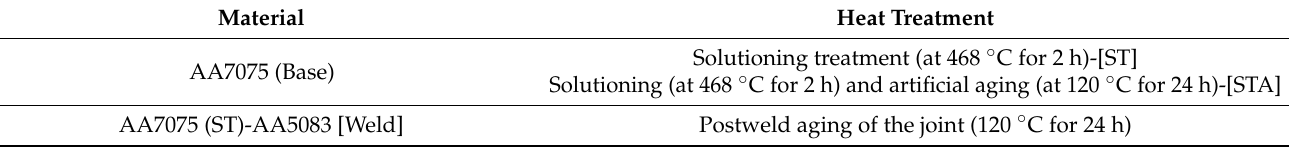
Table 2. Heat treatment